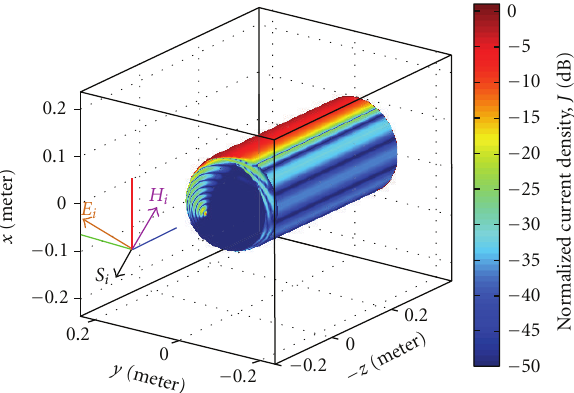
Figure 6: Surface current density using modified PO method for an incident field θ = 20 ◦ , φ = 60 ◦ .